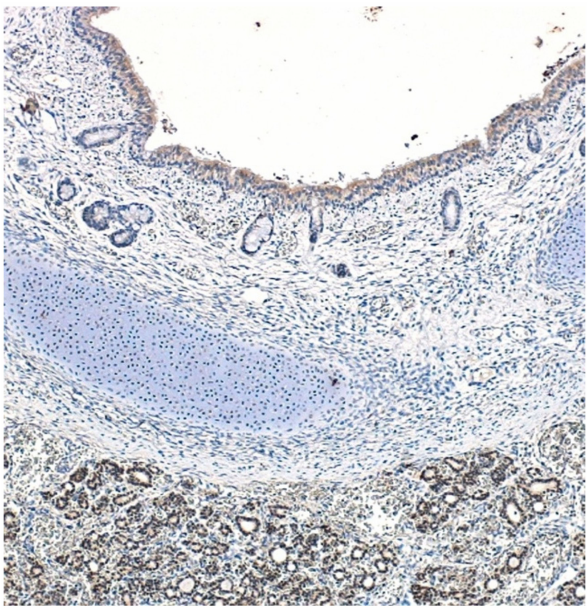
Figure 4. TITF1-positive nuclei (brown) are detected in both normal tracheal and thyroid. epithelium at 14th week of